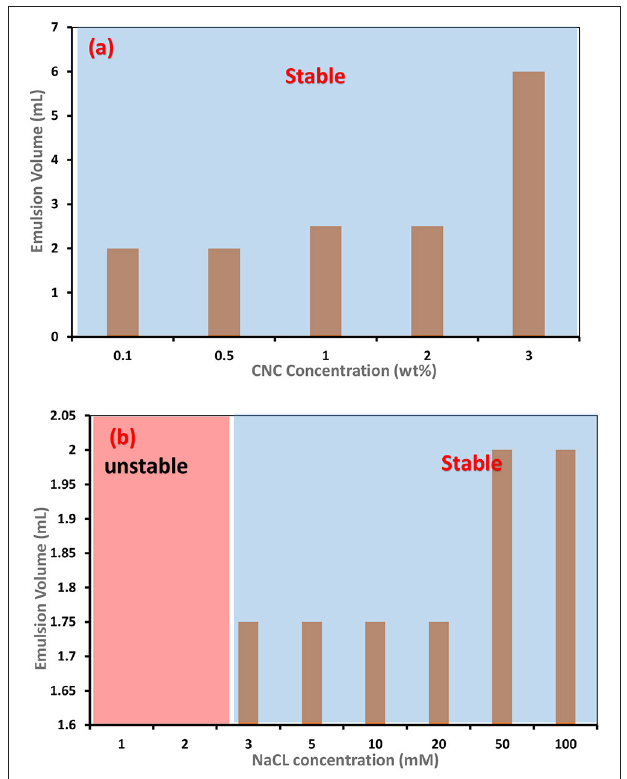
FIGURE 8 | Effect of NaCl addition on the stability of C. Oil/Water emulsions – (a) CNC concentration varied keeping NaCl concentration constant at 100mM (b) NaCl concentration varied keeping CNC concentration constant at 0.1